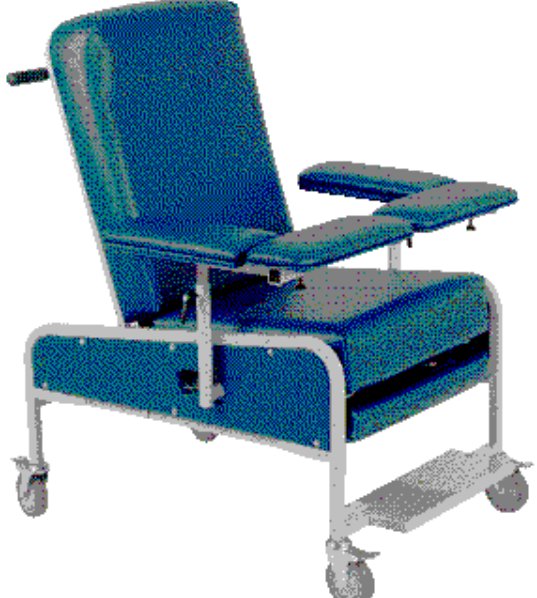
Figure 4-2. VM5000 series phlebotomy